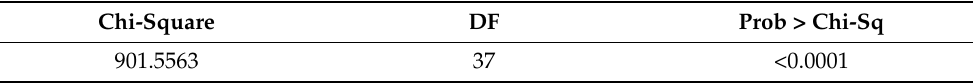
Figure 6. Cartographic representation of energy dependence in EU member states in: ( a ) year 2010 and ( b ) year 2020; excluding Norway. Source: own processing according to [20], processing in JMP. Table 1. Analysis of variability for energy dependence by Kruskal–Wally’s